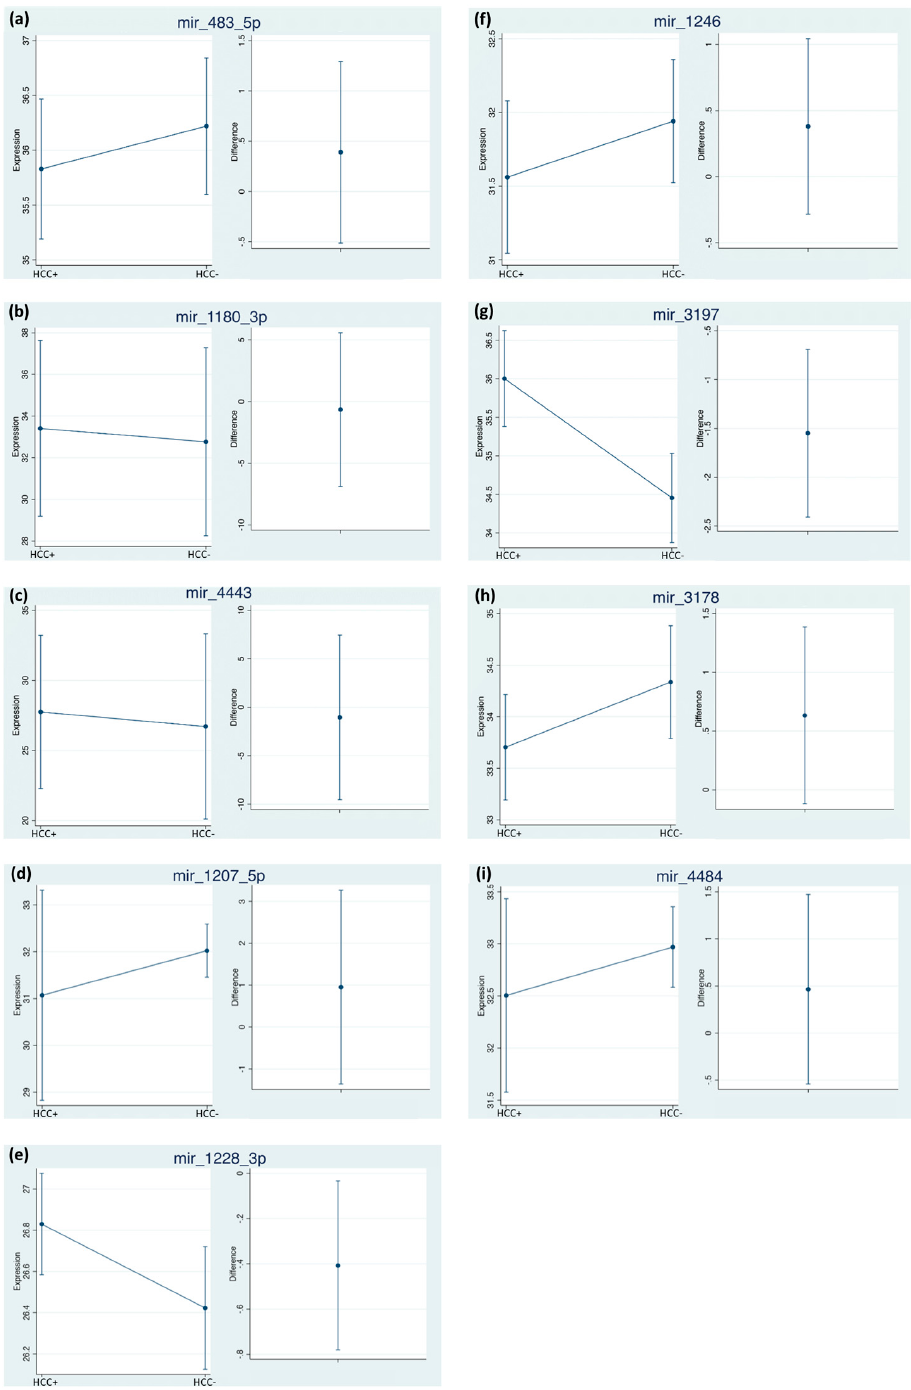
Figure 2. Time-averaged differences of miRNAs between subjects HCC+ vs . HCC − . The estimates were obtained using bootstrapped random-effect generalized least square regression (RE-GLS) calculated on the Cq expression values. Internal cross-validation was performed using bootstrap on 1000 samples with replacement (see statistical analysis for details). The difference is calculated as (HCC+ minus HCC − ), values showing 95% CI crossing 0 are not statistically significant at the 0.05 level.